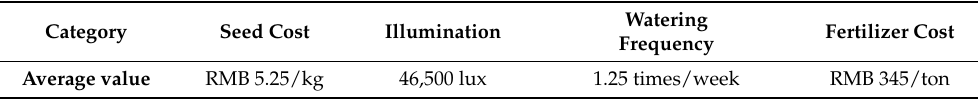
Table 7. Table of calculation results of safety